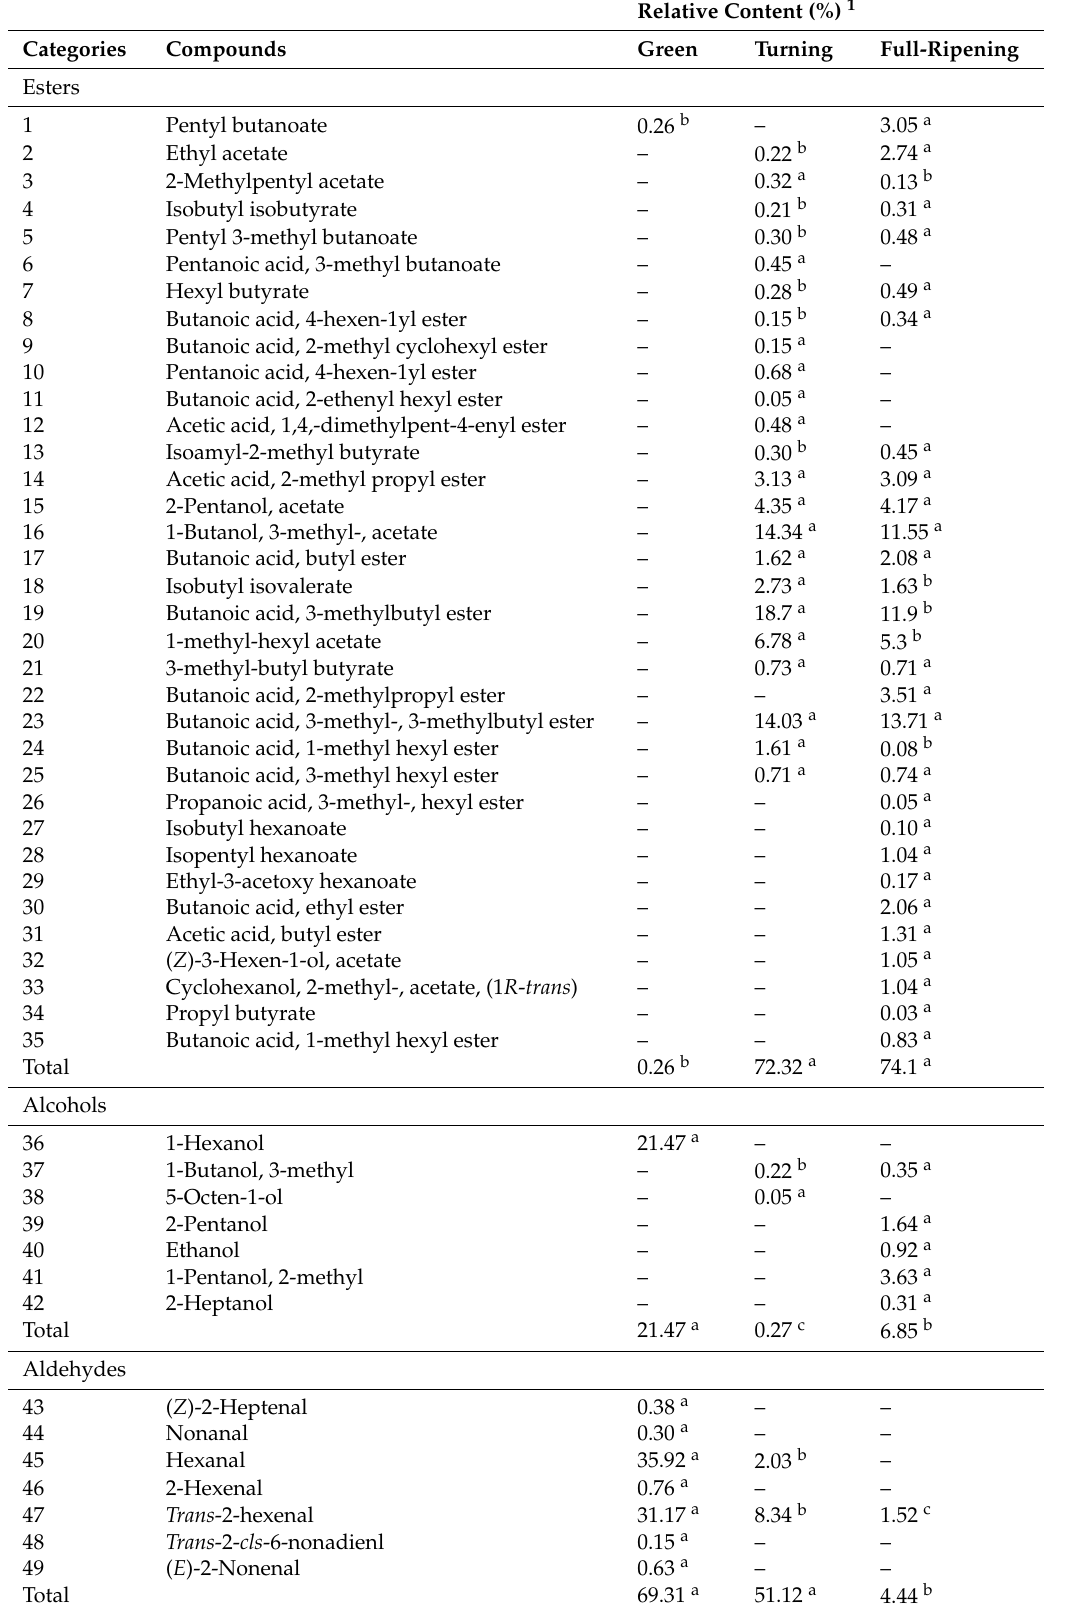
Table 2. Changes in volatiles compounds content in Brazilian banana fruit at various stages of